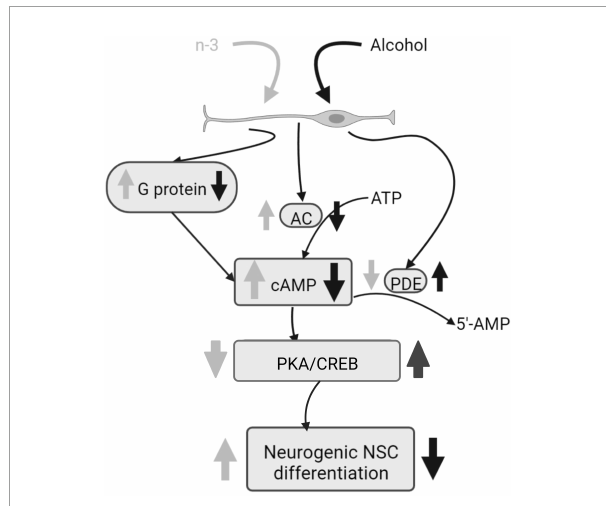
FIGURE2 Alcohol damage of neurogenic NSC differentiation and n-3 effects. Alcohol decreases G protein and AC activation, consequently cAMP signaling is downregulated and PKA and CREB phosphorylation are increased, having a negative impact on NSC differentiation. PDE activity is upregulated by alcohol. However, n-3 intake improves cAMP signaling, decreasing PKA/CREB that promotes NSC differentiation. Also, n-3 downregulates PDE. Created with